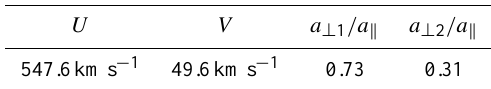
Fig. 4. Deviation between the measured spectrum and the model spectrum in the parameter space spanned by U (Doppler shift) and V (Doppler broadening). Table 1. Key spectral shape parameters obtained from the Cluster data analysis for solar wind